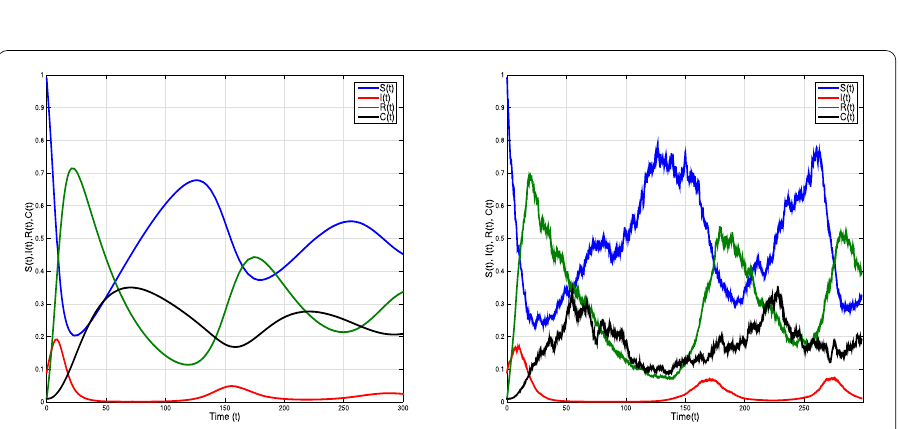
Figure 4 Time domain behaviors of SDDEs model (2) (right) and corresponding deterministic model (1) (left) when R s 0 = 0.38 < 1, with η = 0.0005, ξ = 0.6, β = 0.01, σ = 0.12, α = 0.3, γ = 0.02; τ = 2.5 and white noises ν 1 = 0.02, ν 2 = 0.2, ν 3 = 0.02, ν 4 = 0.2. The figure shows a periodic outbreak due to the time-delay